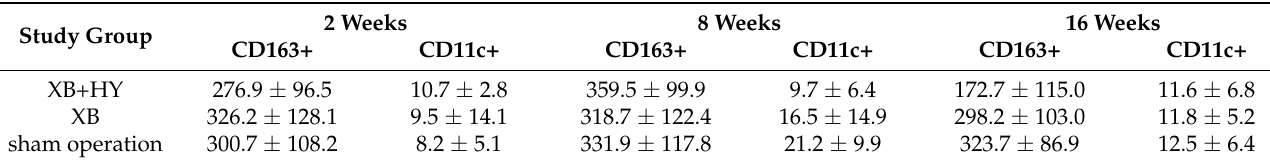
Table 6. Numbers of anti- and pro-inflammatory macrophages within the calvarial defect sites of the different study groups (cells/mm 2 ).